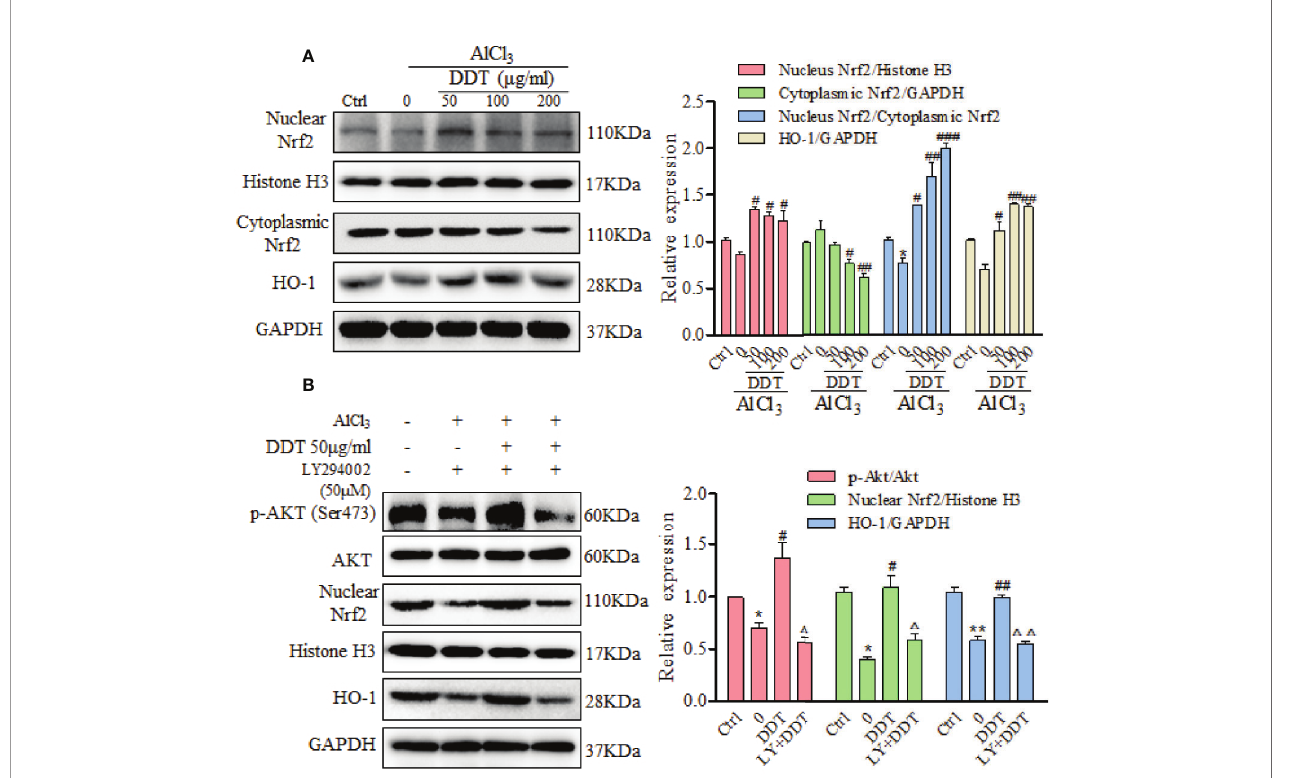
FIGURE 6 | DDT protects PC12 cells against AlCl 3 by activating the Akt/Nrf2/HO1 pathway. (A) After the pretreated with DDT for 48 h and AlCl 3 induction for 6 h, the levels of nuclear and cytoplasmic Nrf2, and HO-1 in PC12 cells were detected by western blot analysis. GAPDH and Histone H3 served as loading controls for the cytoplasmic and nuclear fractions, respectively. After normalization to internal loading control, densitometric intensity of each protein was shown as the respective expression. The ratio of relative nuclear Nrf2/cytoplasmic Nrf2 expression also was calculated and is shown on the right. (B) PC12 cells were pretreated with the PI3K inhibitor, LY294002 (50 m M) for 8 h, and then treated with AlCl 3 and/or DDT for 4 h. Phosphorylation of Akt (Ser473), Akt, nuclear Nrf2, and HO-1 were evaluated by western blot analysis. GAPDH was used as a loading control. Values are means ± standard derivation from three independent experiments. Ctrl: control group. * p < 0.05, ** p < 0.01 vs. control group; # p < 0.05, ## p < 0.01, ### p < 0.001 vs. AlCl 3 -induced model group; D p < 0.05, DD p < 0.01 vs. DDT at 50 m g/ml group. PI3K, phosphatidylinositol 3-kinase; Nrf2, nuclear factor E2 related factor 2; HO-1, heme